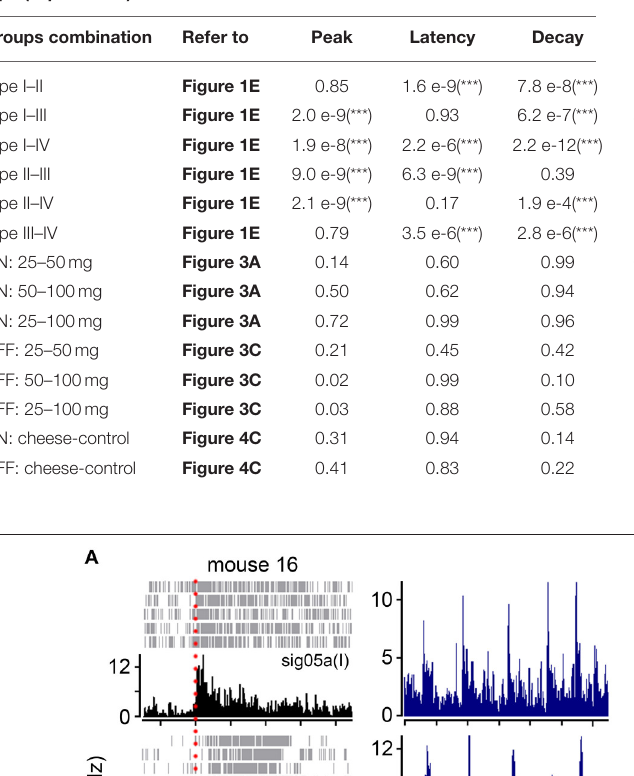
TABLE 2 | The p -values of multiple t -tests with Bonferroni correction for all possible combinations between FRNs types, food amount, and food type ( *** p < 0.001).